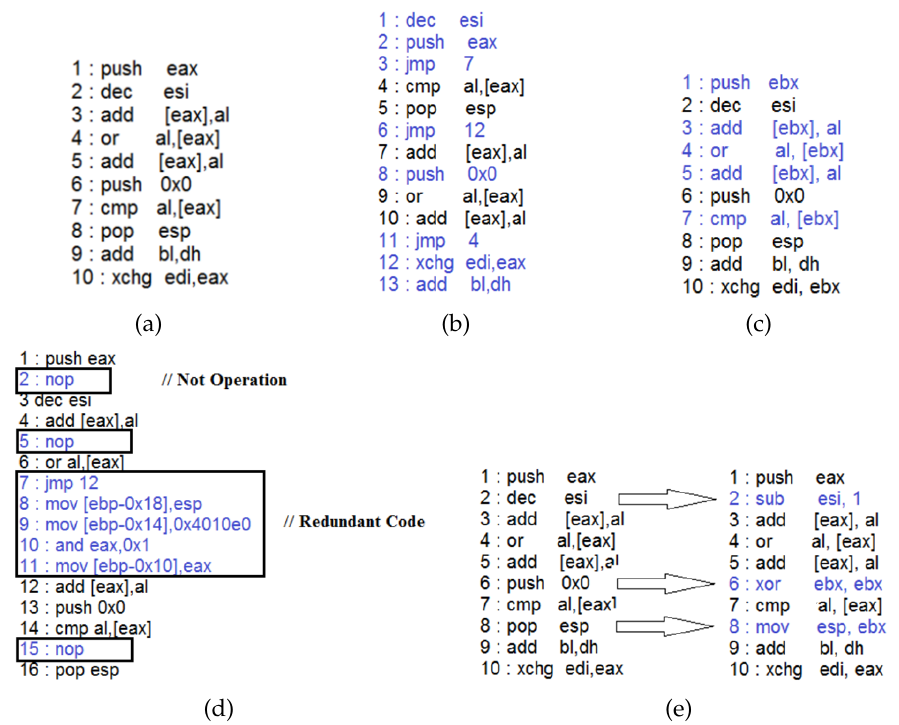
Figure 1. Malware obfuscation techniques: (a) original malware assembly code; (b) after applying jumping obfuscation; (c) after applying renaming obfuscation; (d) after applying redundant code obfuscation; and (e) after applying replacement obfuscation.